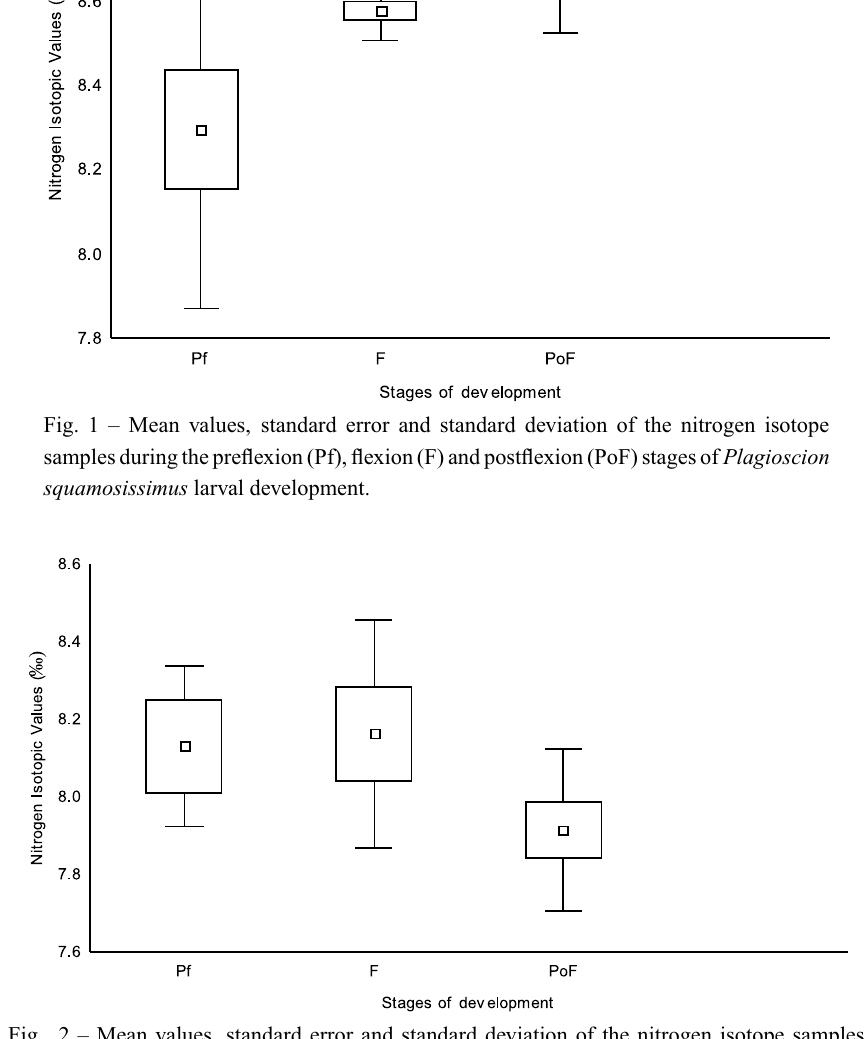
Fig. 2 – Mean values, standard error and standard deviation of the nitrogen isotope samples during the preflexion (Pf), flexion (F) and postflexion (PoF) stages of Hypophthalmus edentatus larval